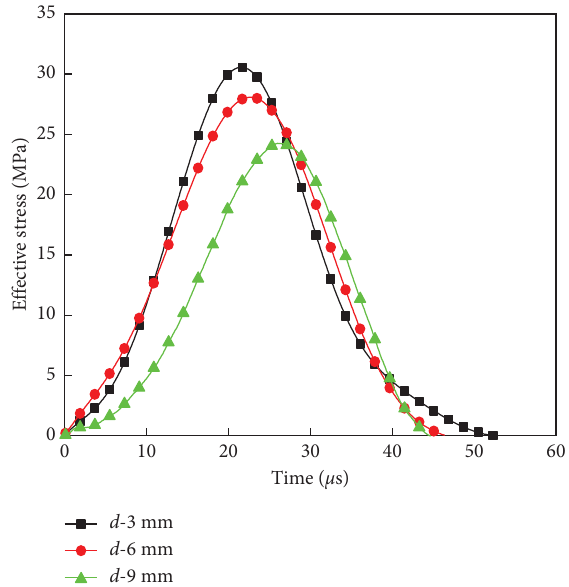
Figure 5: Stress-time history curve of composite specimens with diferent flling medium thicknesses.